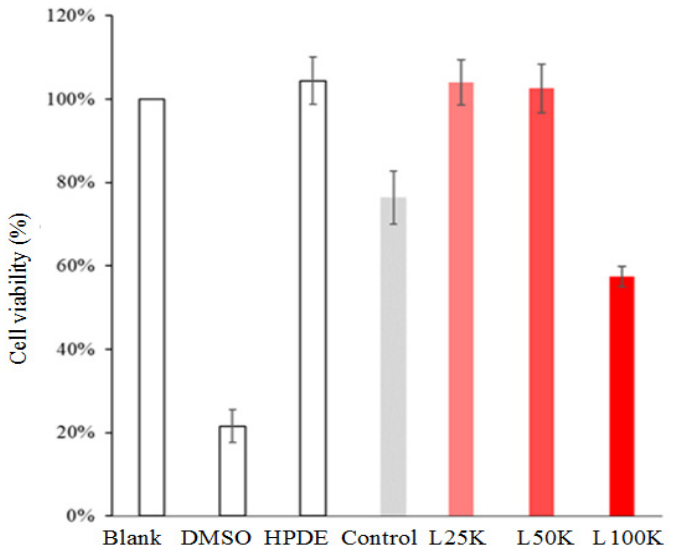
Figure 2. Viability of L929 cell cultures exposed to different extracts of CHA nanorods templated with different concentrations of pharmaceutical heparin ( n = 6).